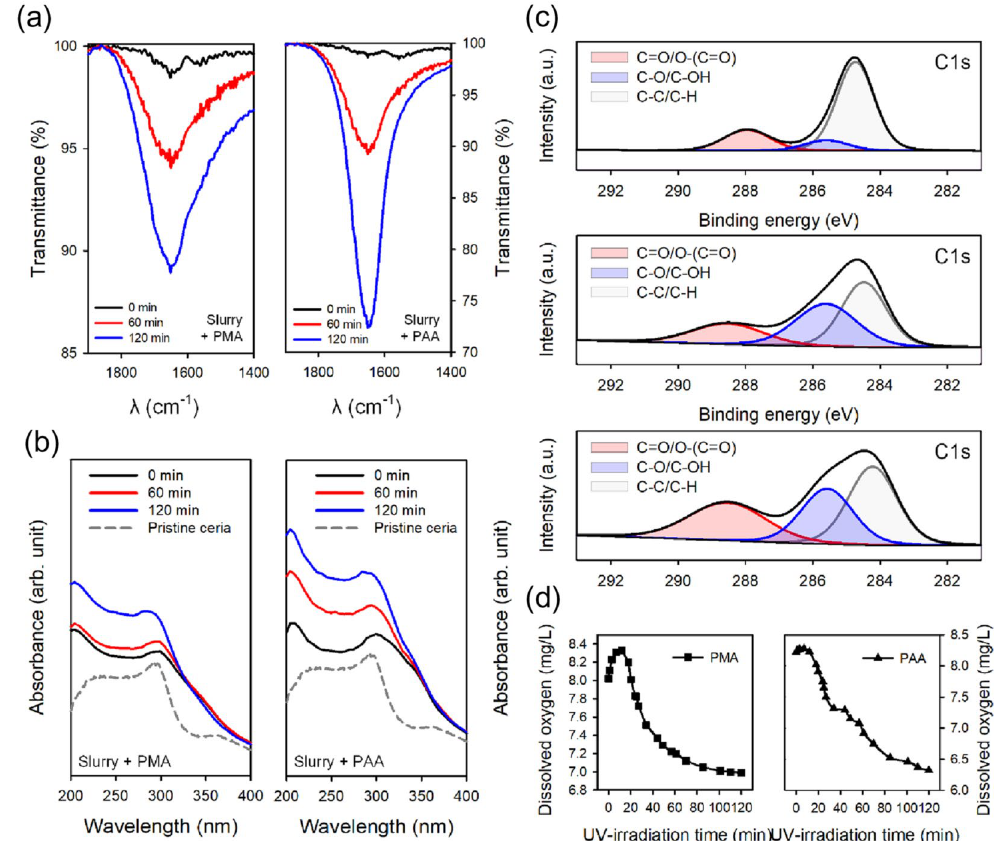
Figure 2. ( a ) Changes in FTIR spectrum of carbonyl band and ( b ) absorbance spectra of ceria slurry with 0.1 wt.% of PMA (left) and PAA (right) during UV-irradiation for 120 min. ( c ) XPS spectra of ceria slurry with 0.1 wt.% of PAA according to UV irradiation time; (top) 0 min, (middle) 60 min, and (bottom) 120 min. ( d ) Changes in dissolved oxygen during UV irradiation on fabricated ceria slurry for 120